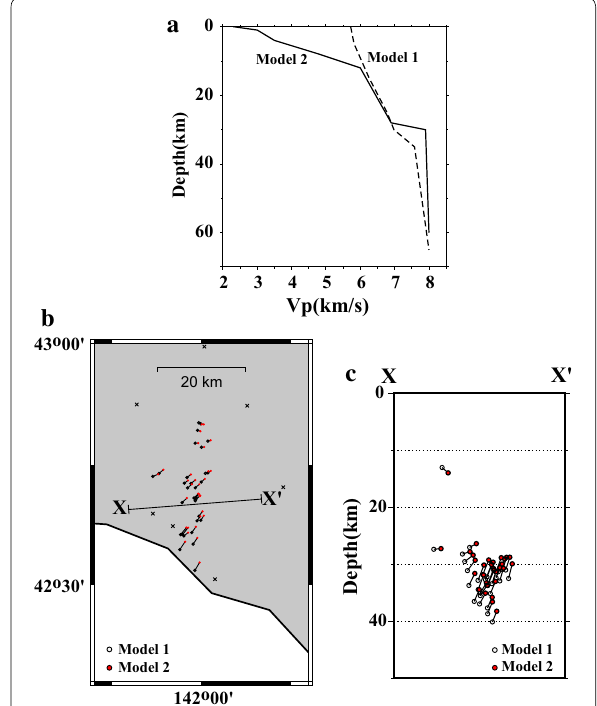
Fig. 9 Test determination of hypocenters using 1D models. a 1D velocity models used for test hypocenter determination. Model 1 is a model from the average over the 3D velocity model by Matsubara et al. (2017a, b). Model 2 is constructed from our structure model in Fig. 5(a). b Comparison of epicenters from Model 1 and 2. c Comparison of hypocenters from Model 1 and 2 in a cross section with respect to X–X’ in